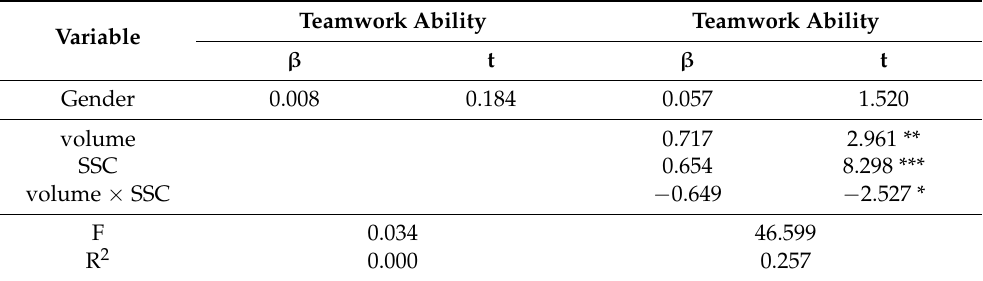
Table 2. Moderated regression